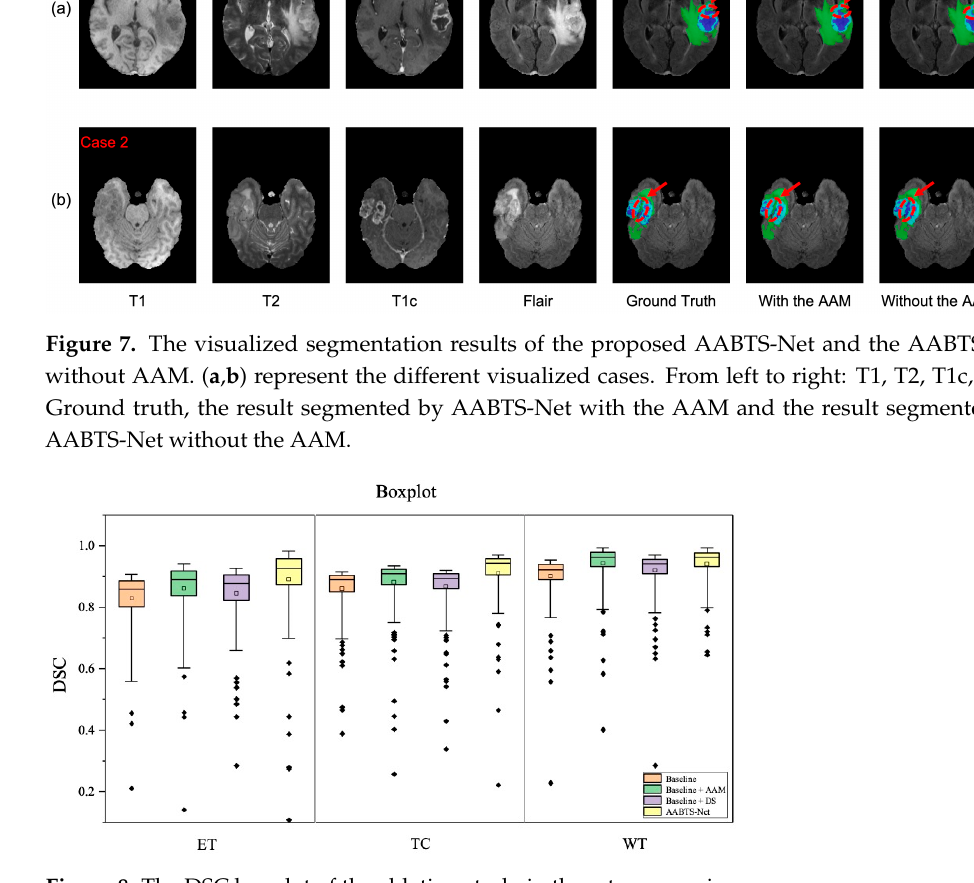
Figure 8. The DSC boxplot of the ablation study in three tumor regions.